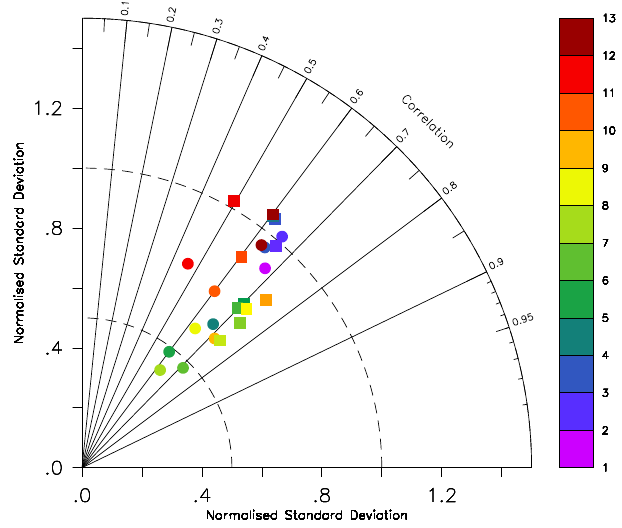
Fig. 2. Taylor diagram of the comparisons between satellite obser- vations and model results of AOD. The comparison with MODIS and MISR are depicted with squares and circles, respectively. The color code denotes the month of the